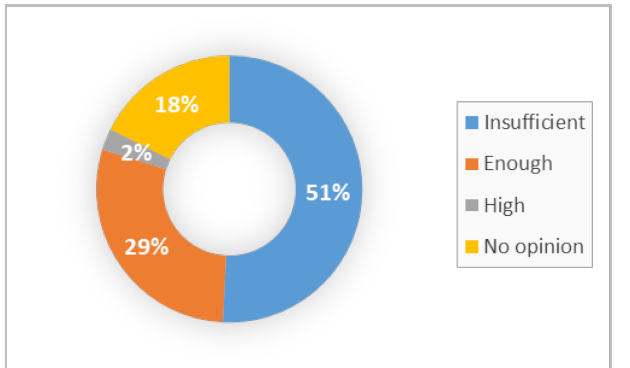
Figure 6. Transitional period for the GDPR